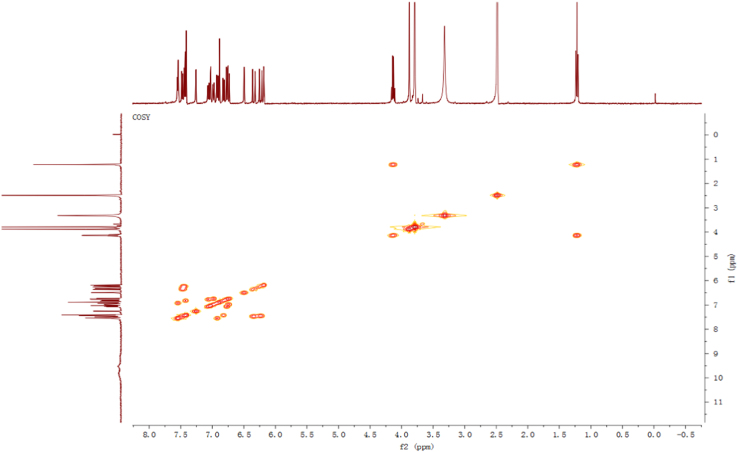
1H-1H COSY spectrum of compound 2.